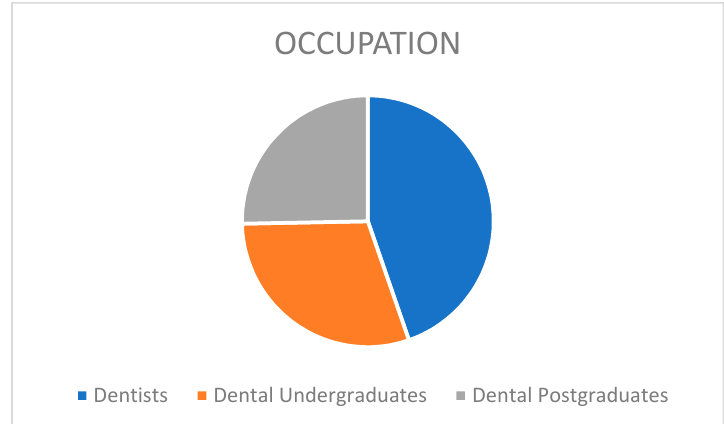
Figure 2. Distribution of respondents belonging to dental community. Table 2. Knowledge Scores of dentists, dental undergraduates, and postgraduates.